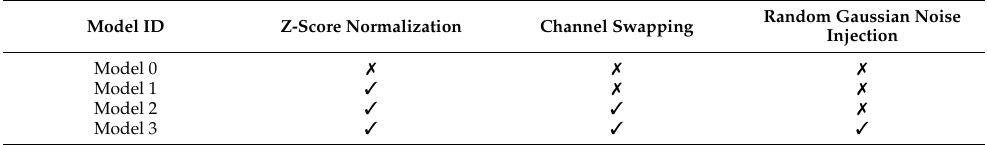
Table 3. Considered variants of the DeepSleep 2.0 model.